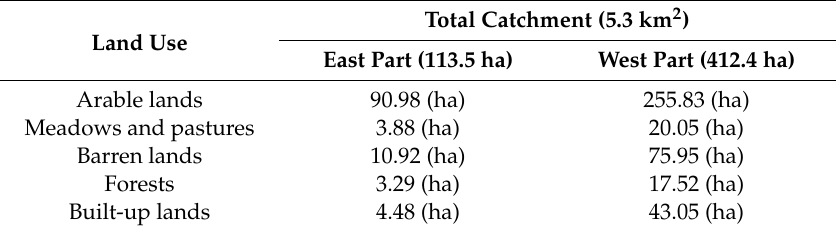
Table 2. Types of land use in the total catchment of Miłkowskie Lake. Land Use